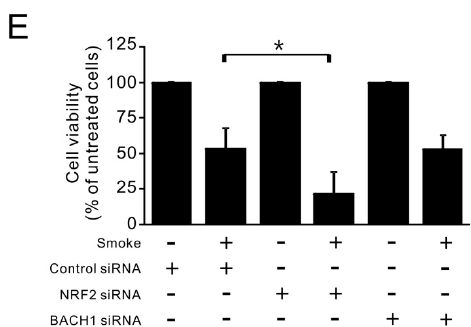
Figure 5. Contributions of NRF2 and BACH1 to HO-1 protein level and cell viability in response to smoke exposure. ( A ) HBE1 cells transfected with siRNA targeting NRF2 and BACH1 were subsequently exposed to cigarette smoke. After 24 h of exposure, cells were collected for protein analysis by immunoblotting. ( B – D ) The relative expression of HO-1/ β -tubulin ( B ); NRF2/Nucleolin ( C ); and BACH1/Nucleolin ( D ) were quantified from three separate experiments as fold relative to that of untreated HBE1 cells with control siRNA. * p < 0.05 ( n = 3; mean ± S.D.); ( E ) HBE1 cells with NRF2 or BACH1 siRNA transfection were exposed to cigarette smoke for 72 h and cell viability was determined by MTS assay ( n = 3; mean ± S.D.). * p < 0.05.